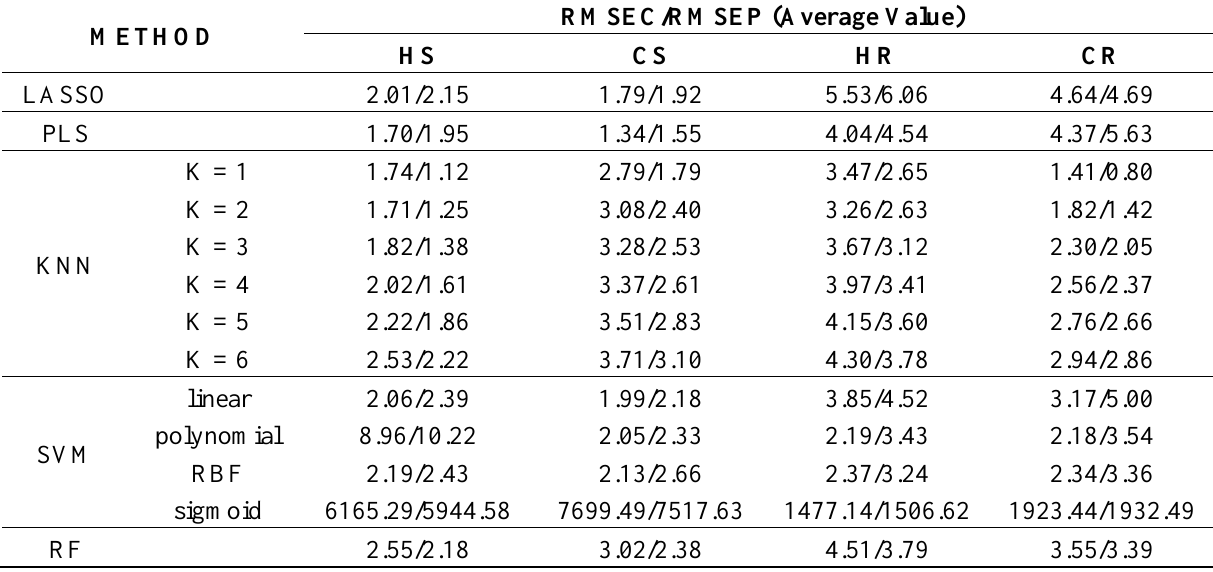
Table 5. Comparison of prediction performance of five methods, based on 1000 runs of k-fold (k = 10)